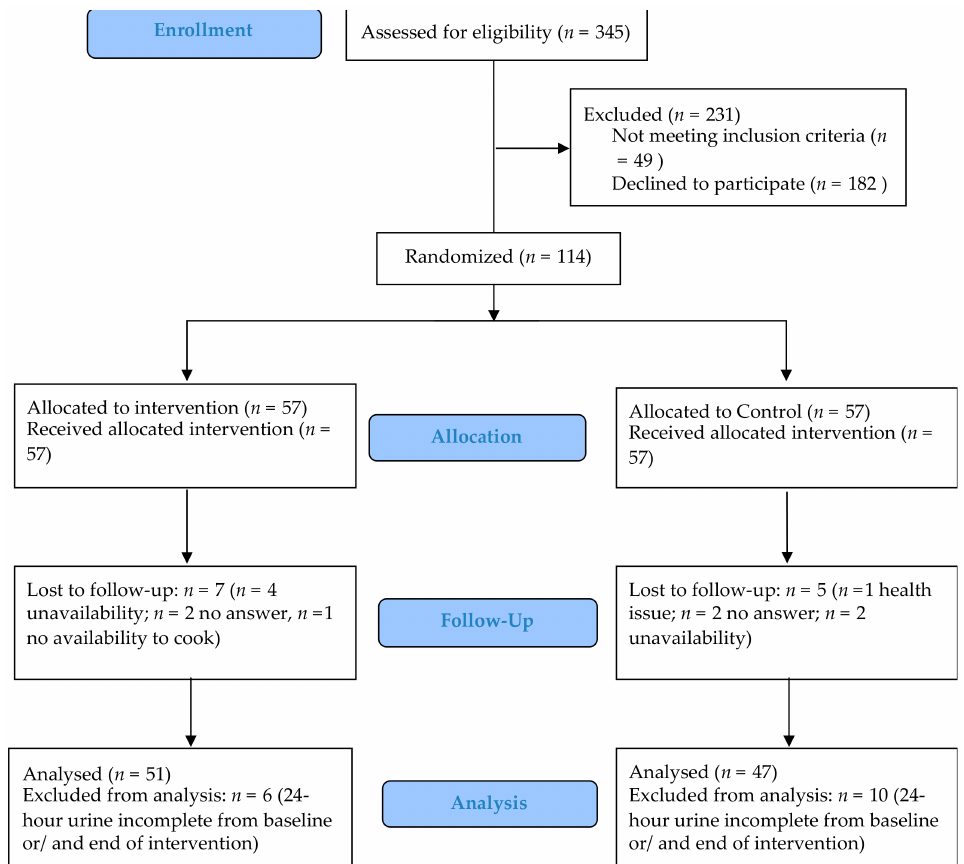
Figure 2. Flow diagram of participants in an intervention to reduce salt